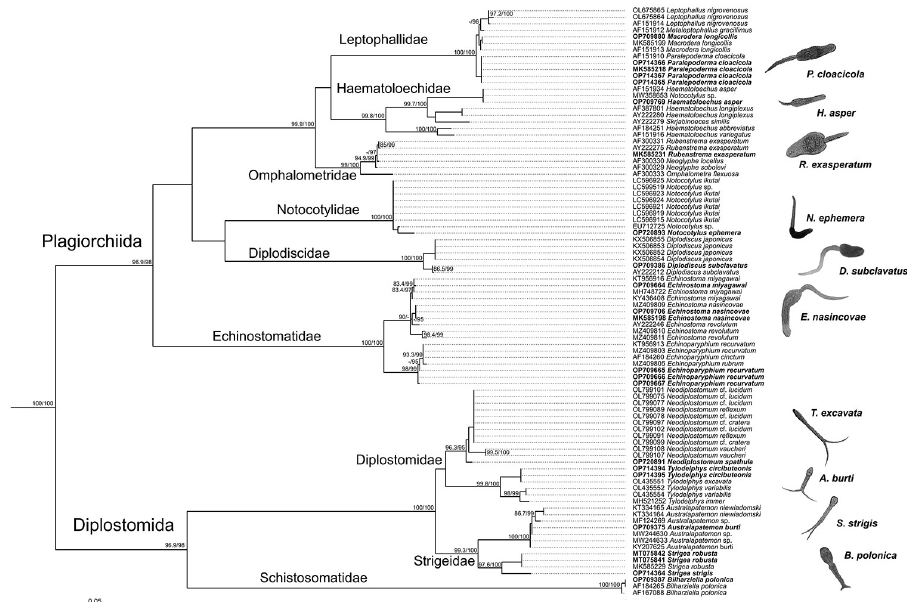
Fig 3. Phylogenetic relationship of trematodes based on 28S rRNA sequences. Maximum-likelihood phylogenetic tree of trematode species inferred using IQ-TREE with 1,000 SH-like approximate likelihood ratio test (SH-aLRT) and ultra-fast bootstrap (UFboot) replicates each. AY222162, MK387333 Aspidogaster and AY222163 Multicalyx are used as an outgroup. Numbers at nodes indicate SH-aLRT support ( � 80%)/UFboot support ( � 95%); values less shown with